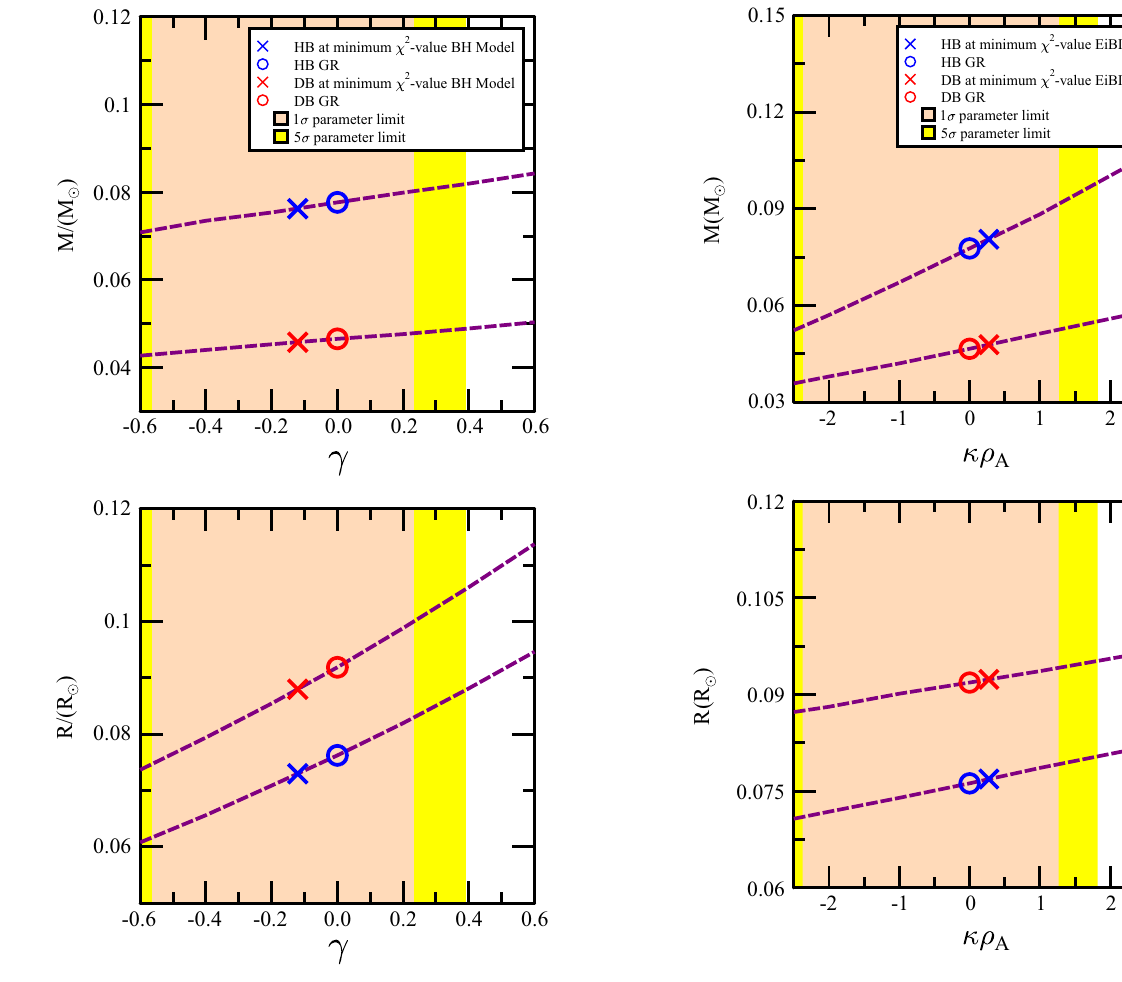
Fig. 5 MMHB and M (DB limit) as a function of the γ parameter of BH theory